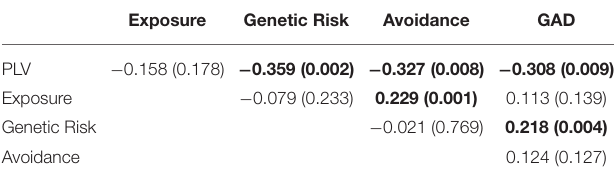
TABLE 3 | Correlation